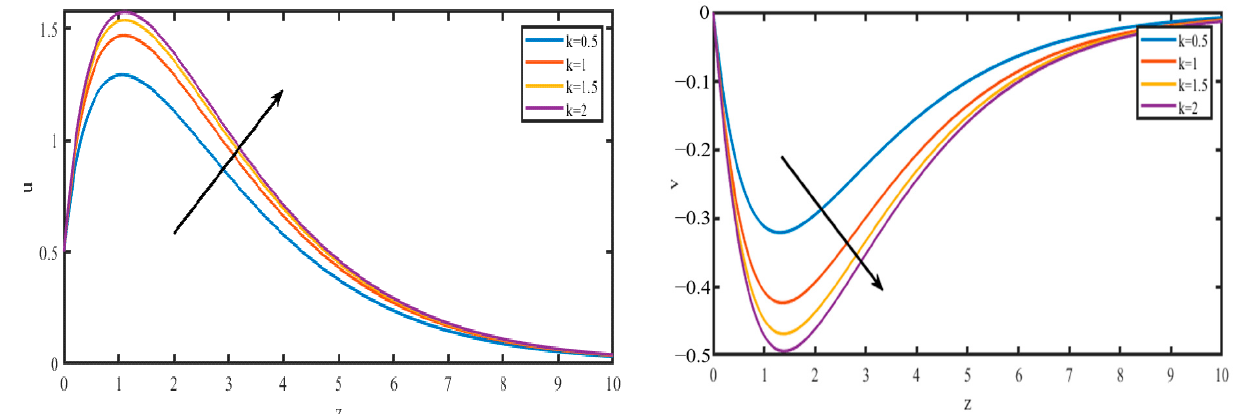
Figure 5. The velocity patterns for u and v plotted vs. k, with M = 2.0, R = 1.0, Gr = 5.0, S = 1.0, Gm = 3.0, m = 0.20, Pr = 0.710, H = 1.0, Sc = 0.220, Kc = 1.0, n = 0.50, t = 0.50, So = 0.50, F = 1.0.